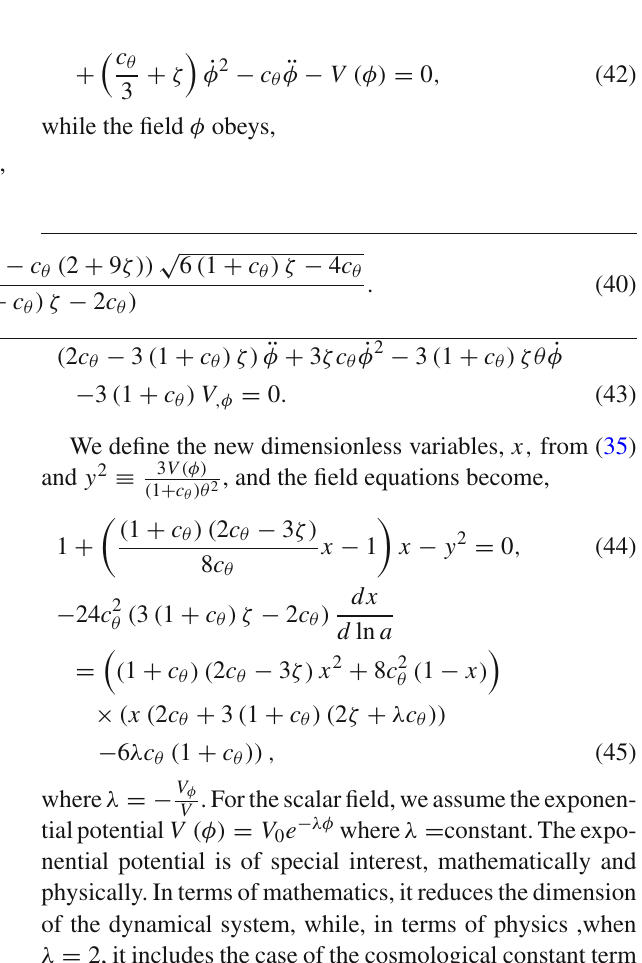
Fig. 2 Region plots in the space of parameters { c θ ,ζ } , where the critical point x 0 is physically accepted (left fig.) and the exact solution at this point describes an accelerated universe (right